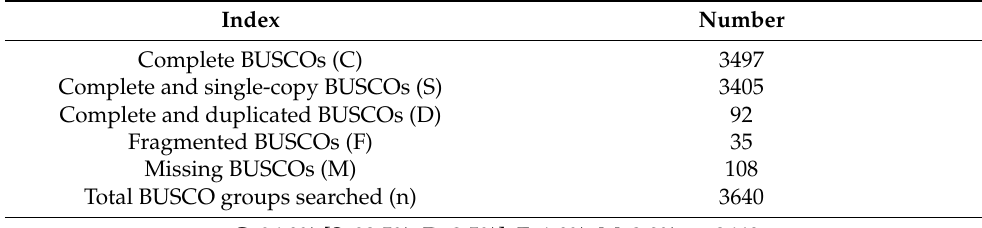
Table 4. Genome assessment based on BUSCO annotations.